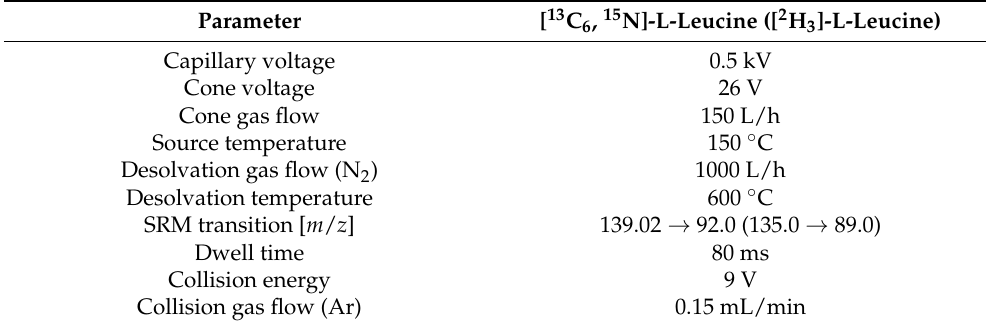
Table 3. Optimized parameters for the MS/MS detection of [ 13 C 6 , 15 N]-L-leucine and [ 2 H 3 ]-L-leucine in positive heated ESI and